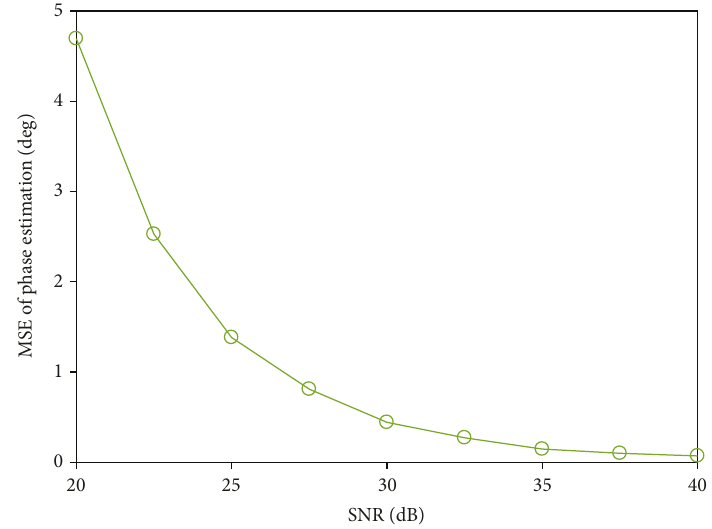
Figure 10: The phase calibration error under di ff erent SNR conditions.